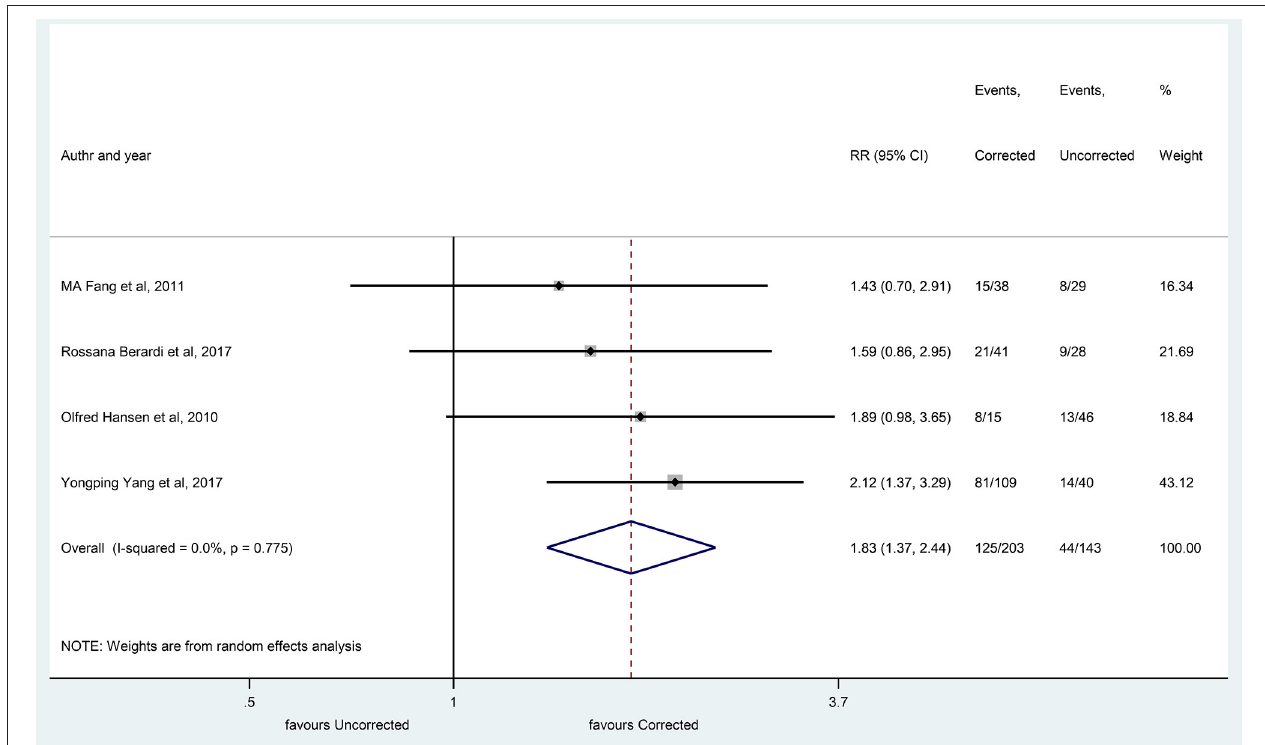
FIGURE 10 | The overall survival rates after correction of hyponatremia at 10 months (corrected and uncorrected hyponatremic patient groups). Black diamonds represent the individual effects of studies, and vertical lines show the corresponding 95% CI. The size of the gray squares reflects the individual weight of a particular study. The blue diamond shows the overall or summary effect. The outer edges of the diamonds represent the CIs. RR, risk